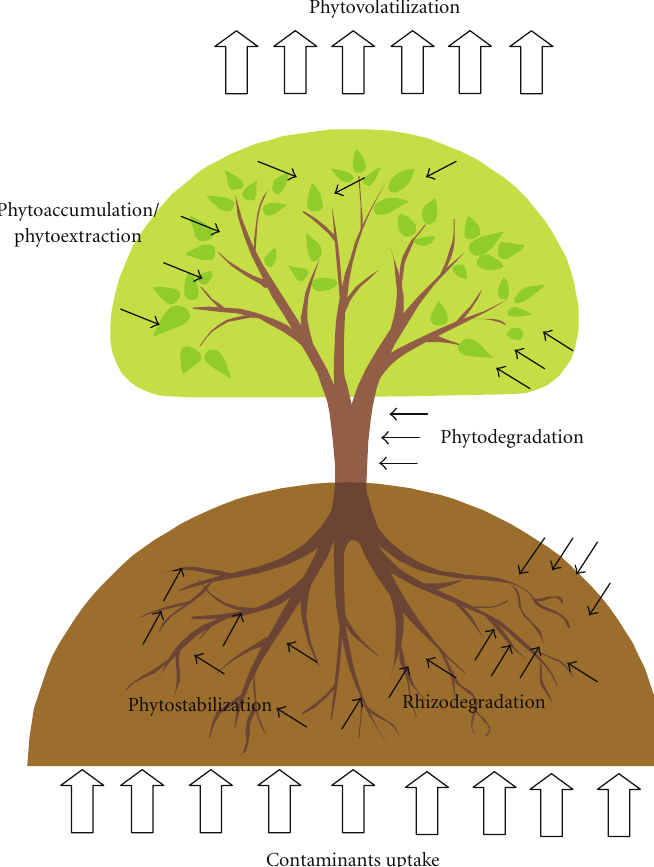
Figure 2: The mechanisms of heavy metals uptake by plant through phytoremediation